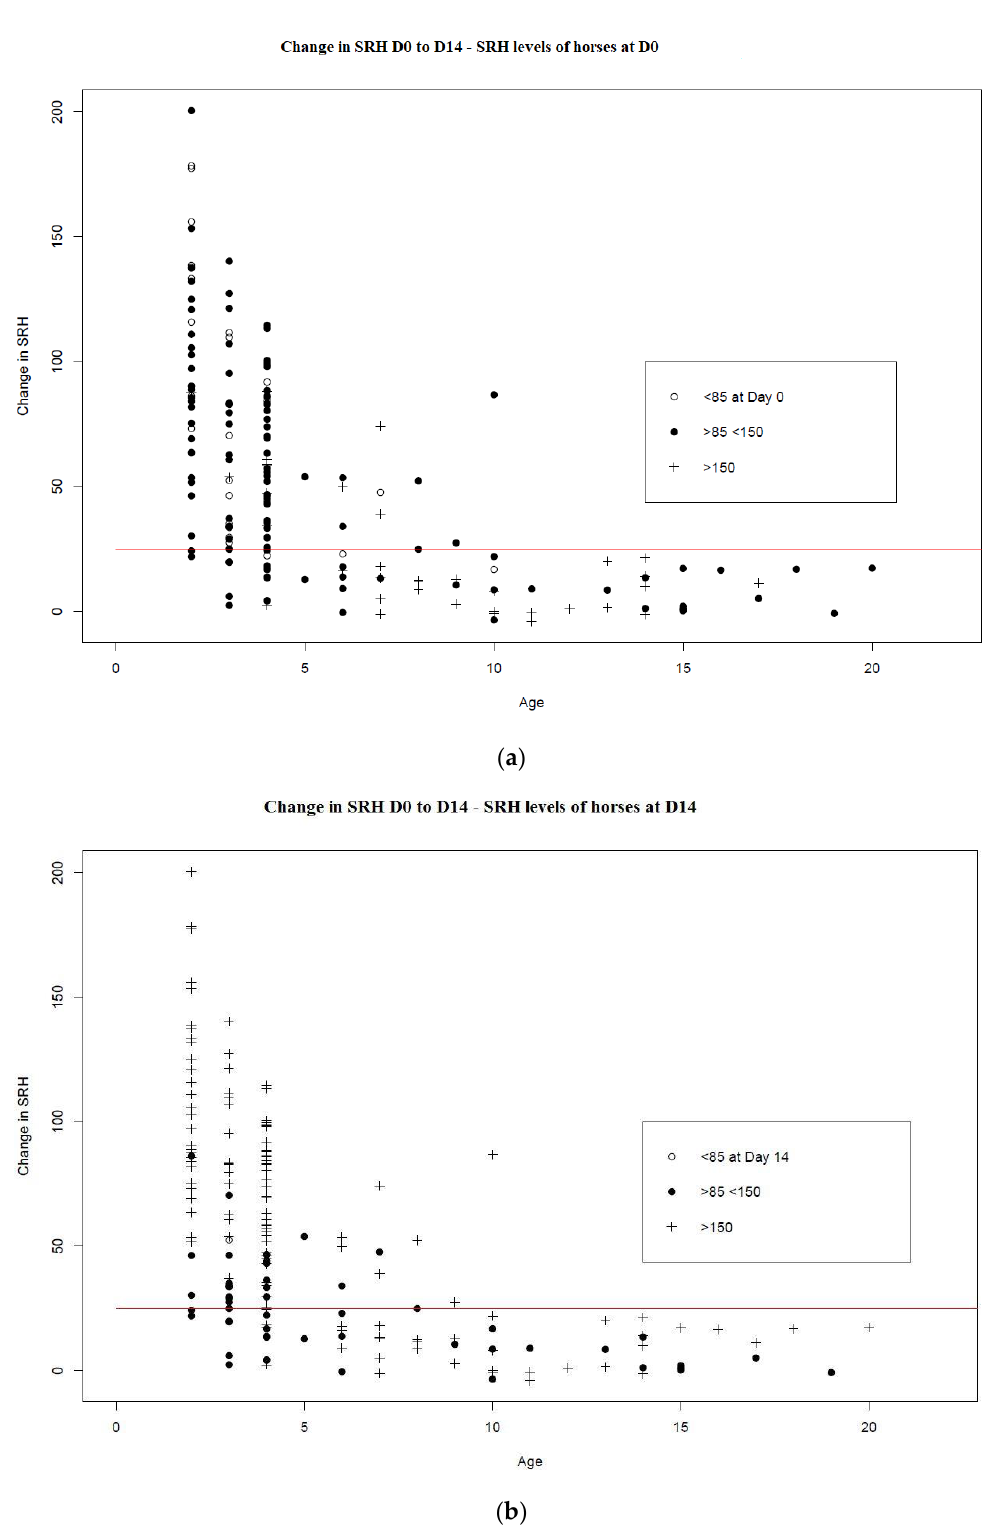
Figure 4. Both Figure 4a,b represent the change in SRH antibody titres between days 0 and 14 ( n = 188) by age. The red horizontal line is drawn at 25 mm 2 , as an increase of ≥25 mm 2 is considered significant (i.e., a seroconversion). The figures differ in that ( a ) indicates the titres for the individual horses on day 0, and ( b ) indicates the titres for the same horses on day 14 post-vaccination. The empty circles represent horses with SRH titres <85 mm 2 , the filled circles represent horses with SRH titres >85 mm 2 but <150 mm 2 ,and the crosses represent horses with SRH titres >150 mm 2 .